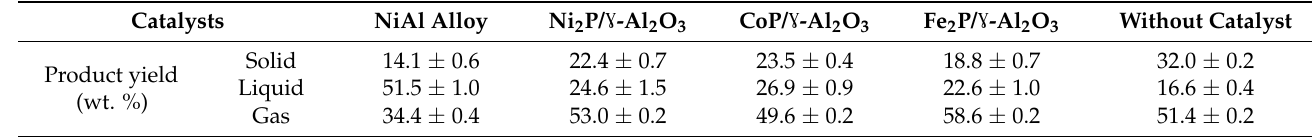
Figure 2. H 2 -TPR profiles of 5 wt.% (a) Ni 2 P/ ɣ -Al 2 O 3 , (b) CoP/ ɣ -Al 2 O 3 , and (c) Fe 2 P/ ɣ -Al 2 O 3